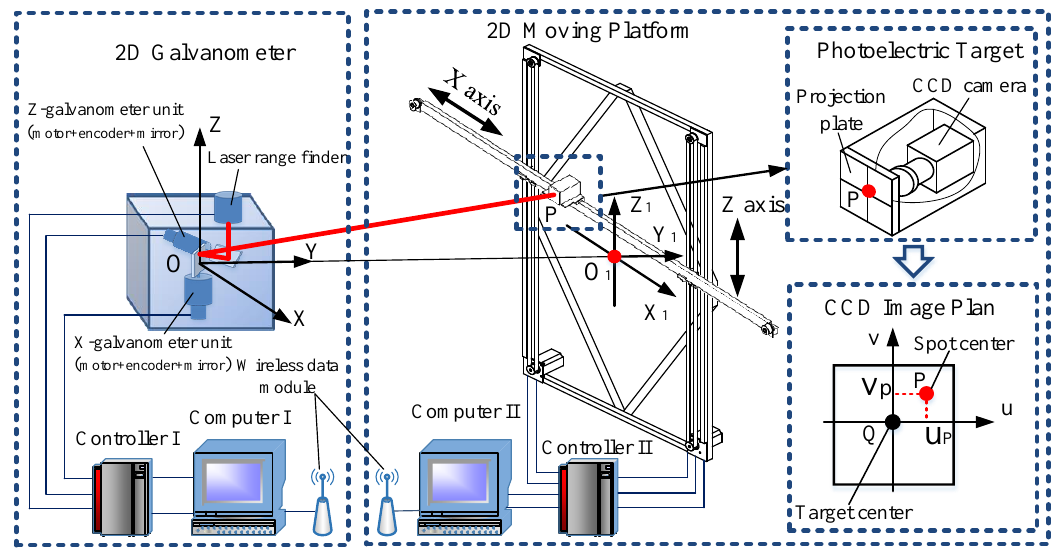
Figure 3. Experimental system configuration.